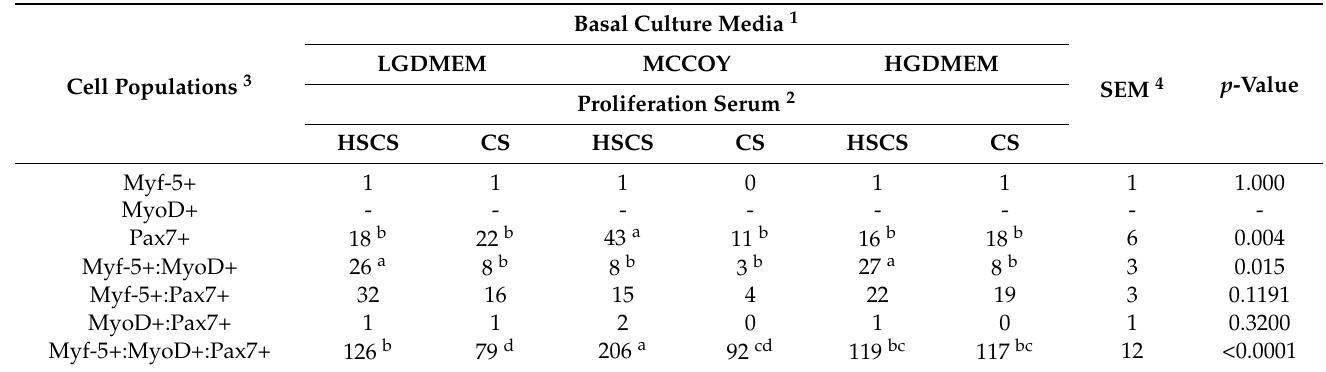
Table 2. The effect of basal culture media and proliferation serum on proliferating satellite cell heterogeneity at 72 h post-plating.